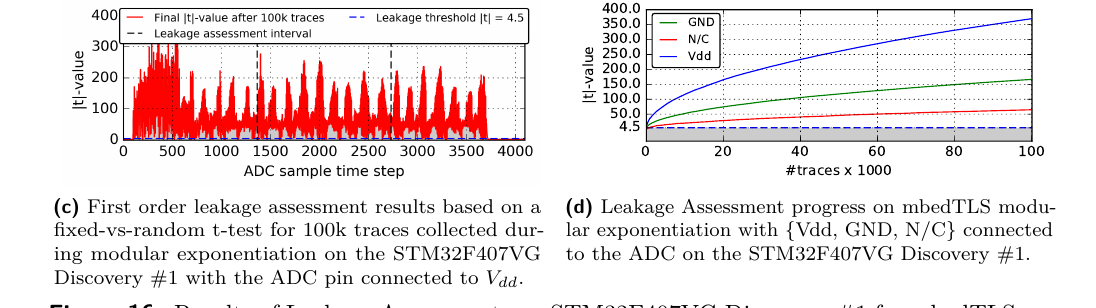
Figure 16: Results of Leakage Assessments on STM32F407VG Discovery #1 for mbedTLS modular